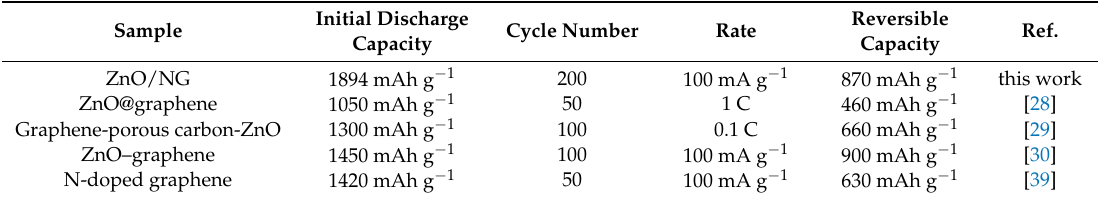
Table 1. Comparison of electrochemical performances between the N-doped graphene and ZnO/NG composite.